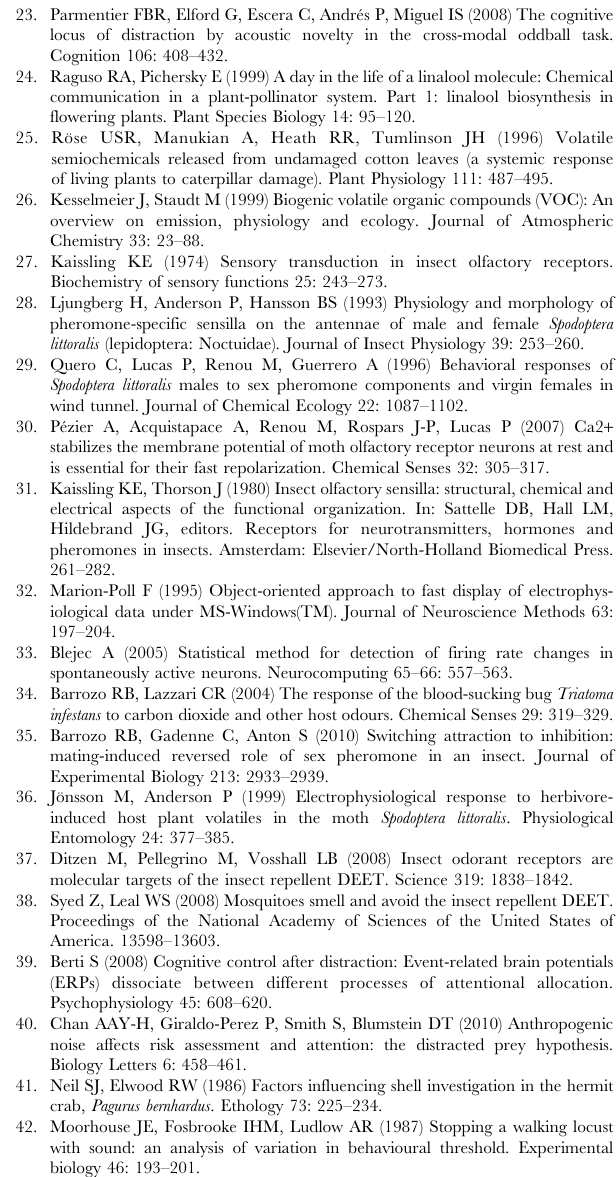
Figure S1 Olfactory stimulation protocols for the behavioral experiments. The horizontal bars show stimulations with PV (grey) and Phero (white) for the five series of experiments. Between odor stimulations, an equivalent flow of humidified air (dashed bars) ensured a constant rate of the total airflow. Figure S2 Lin addition modifies the PWR. Video reconstruction of an individual track showing the effects of Lin addition on the PWR. When stimulated by Phero, a male S. littoralis walked upwind (white section of the track from 0 to 60 s). At addition of Lin (green track section, from 60 to 120 s), the male decreased its speed